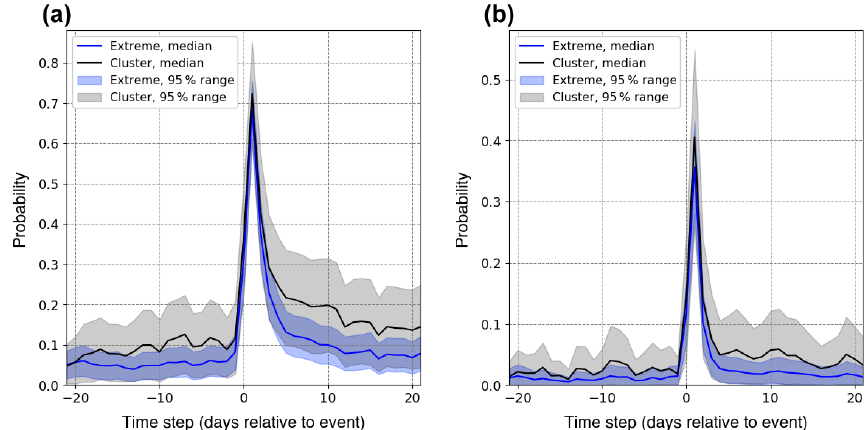
Figure 12. Probability of exceeding the (a) 95th and (b) 99th percentiles of daily discharge around an extreme precipitation event that is part of a 21d cluster (black) and around any random precipitation extreme (blue) across catchments with a mean elevation smaller than 1500m. Solid lines correspond to the multi-catchment median and shading to the 95% range.